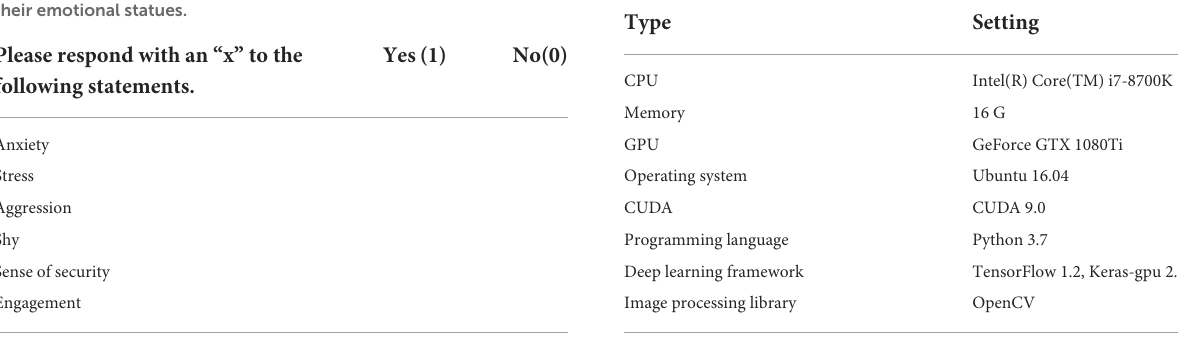
TABLE 5 Hardware and software settings for the experiment.